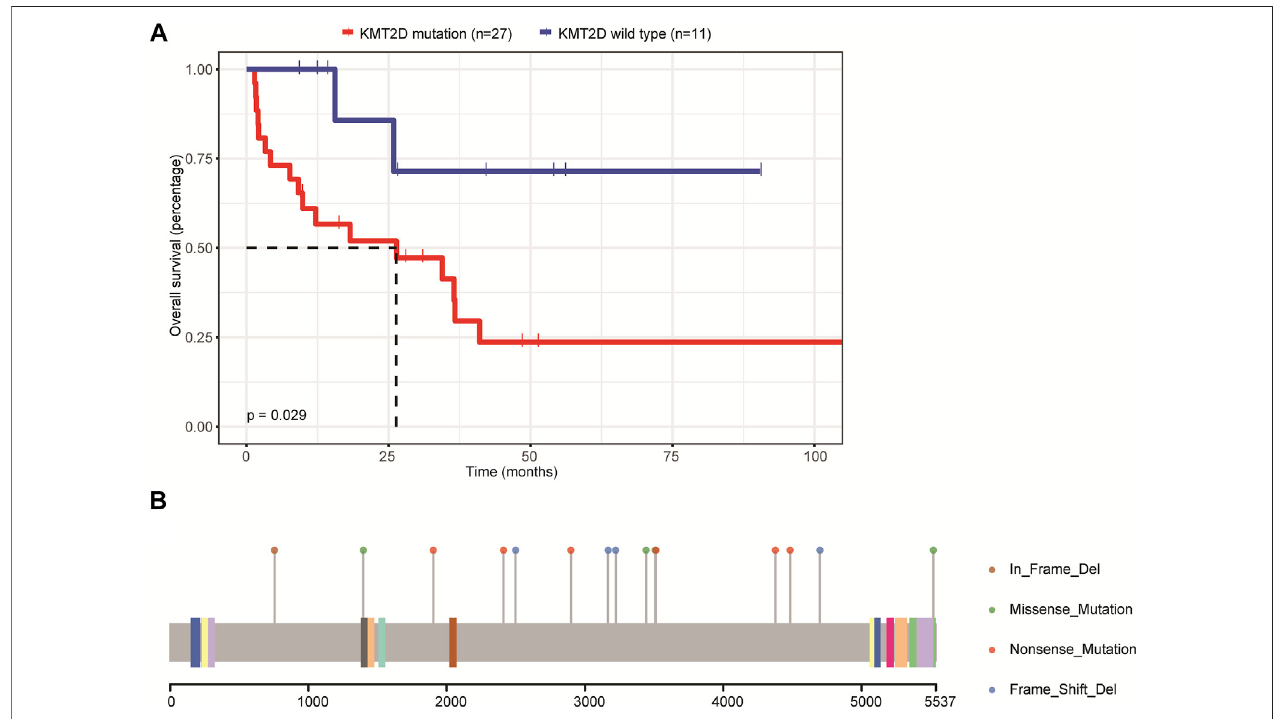
FIGURE 3 | The relationship between mutations and the prognosis ofpatients with primary CNS DLBCL. (A) The K-M curveshowed KMT2D mutation was linked to lower OS. (B) The mutation schematic diagram of the KMT2D gene in its domain region.